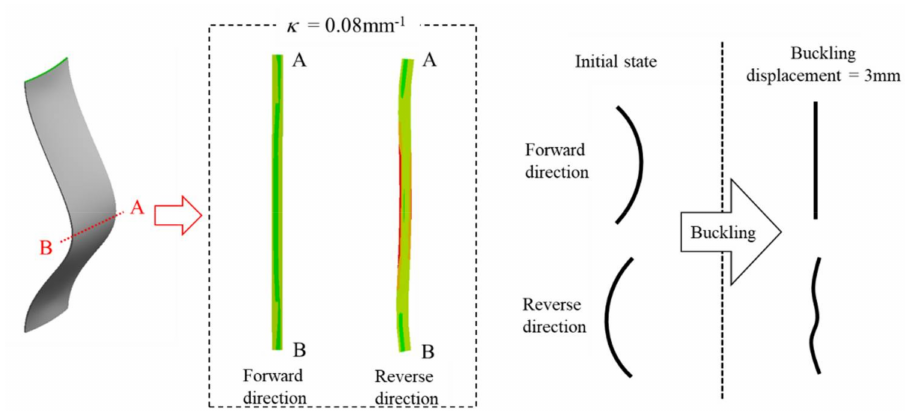
Figure 16. The numerically obtained results and schematic drawings of the cross-sectional shape of the center of the material for forward and reverse buckling with κ = 0.08 mm − 1 when the buckling displacement is 3